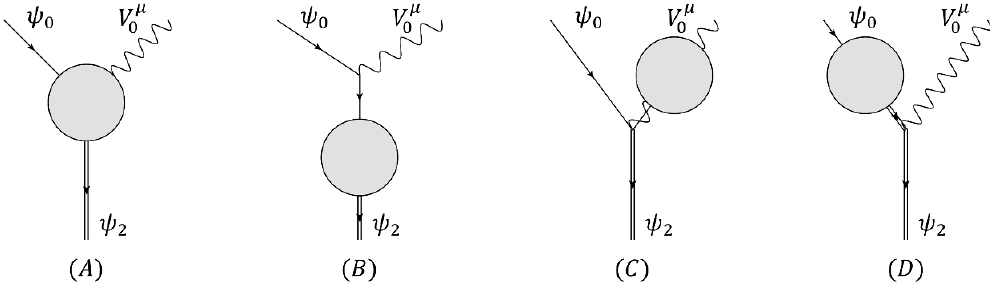
Figure 6 . Contributions to the (cid:22) 2 { 0 { V 0 vertex. See caption of (cid:12)gure 4 for more